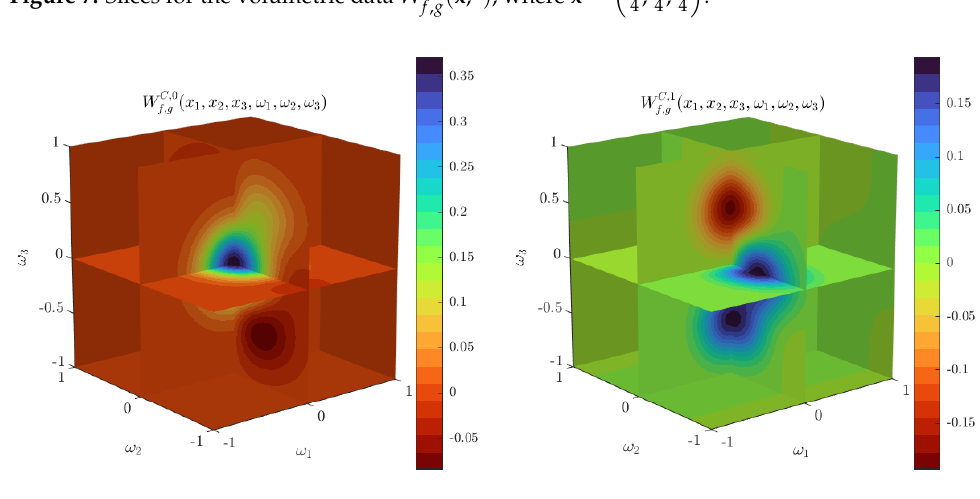
Figure 7. Slices for the volumetric data W R